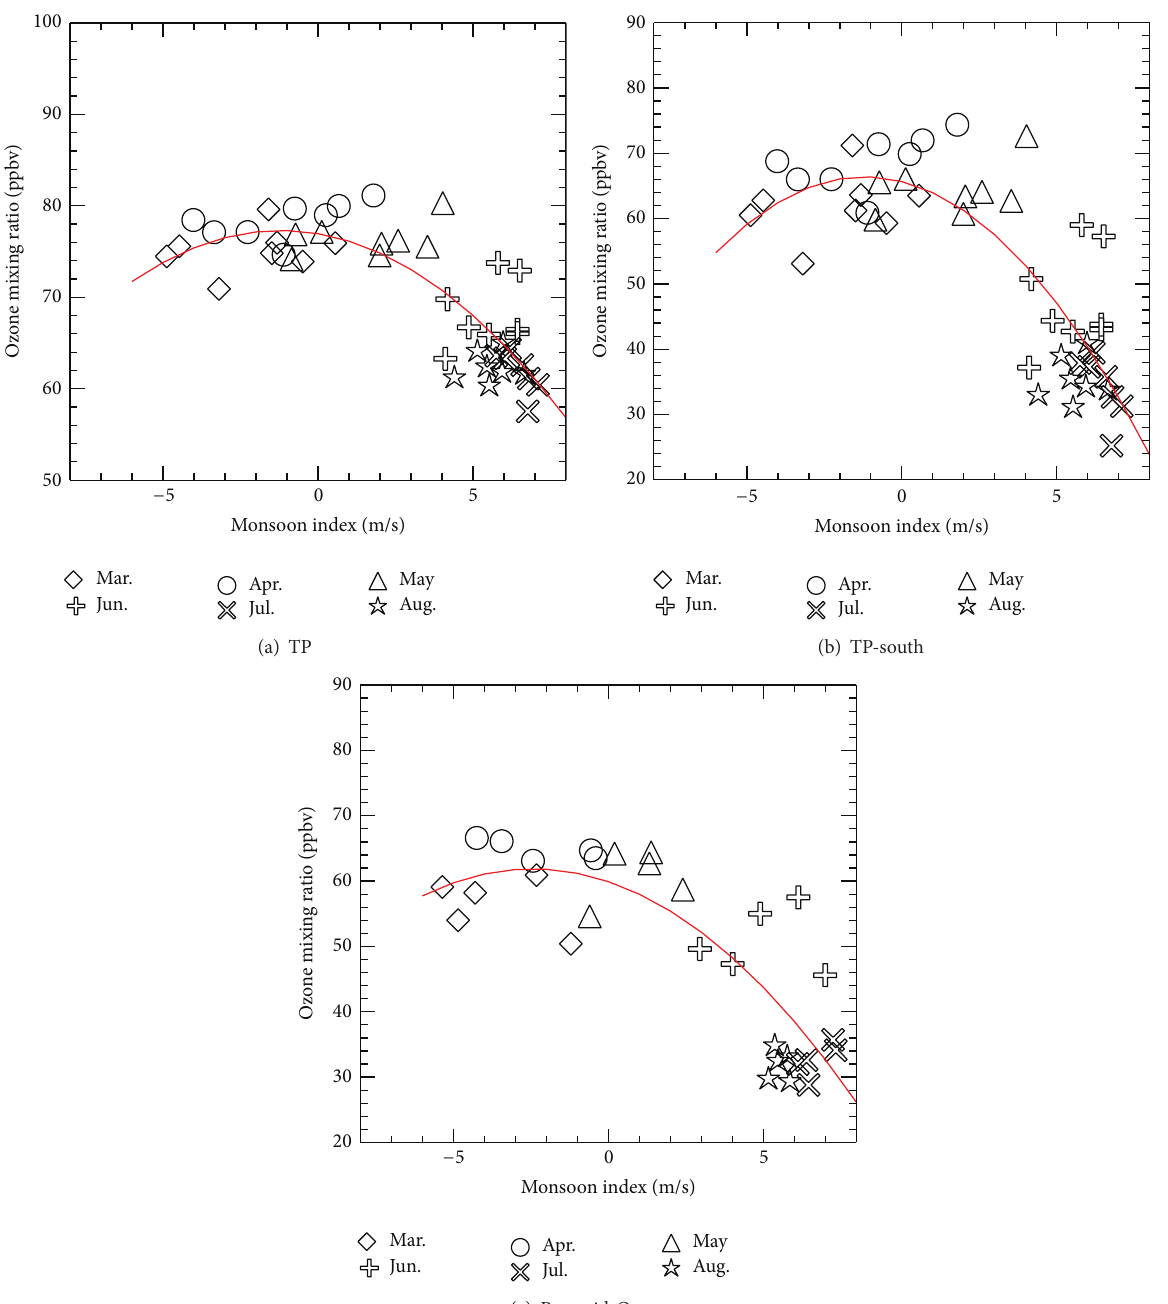
Figure 7: Correlation between the Indian Monsoon index and PC2-O 3 over (a) the Tibetan Plateau and (b) south of the Tibetan Plateau between March 1996 and June 2003, and (c) the correlation between the Indian Monsoon index and surface observations of ozone from Pyramid between March 2006 and December